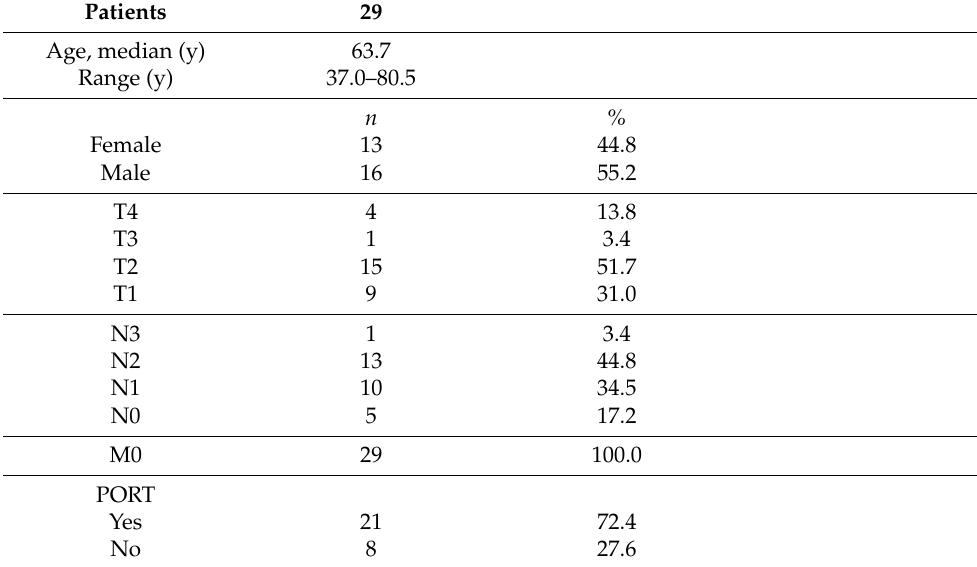
Table 2. Patient and tumor characteristics of the in-house cohort. PORT; post-operative radiotherapy. y; years, T; T-stage, N; N-stage, M;